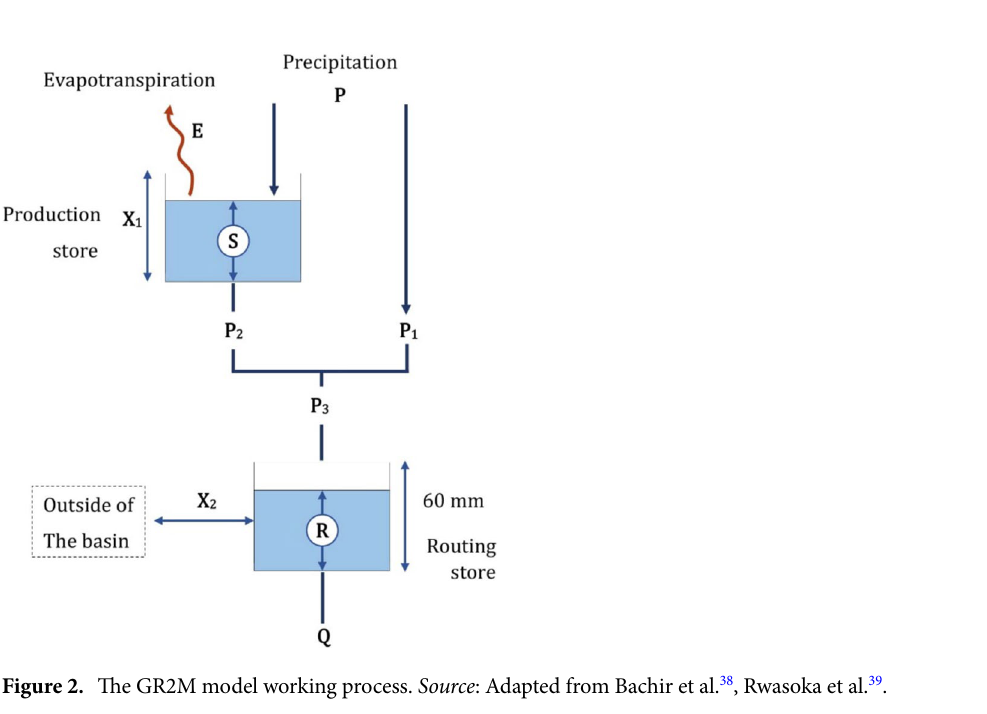
Figure 1. The station locations of rainfall, runoff, and weather stations of the study area. (This map was created by QGIS version 3.12, which can be accessed on https:// qgis. org/ en/ site/).